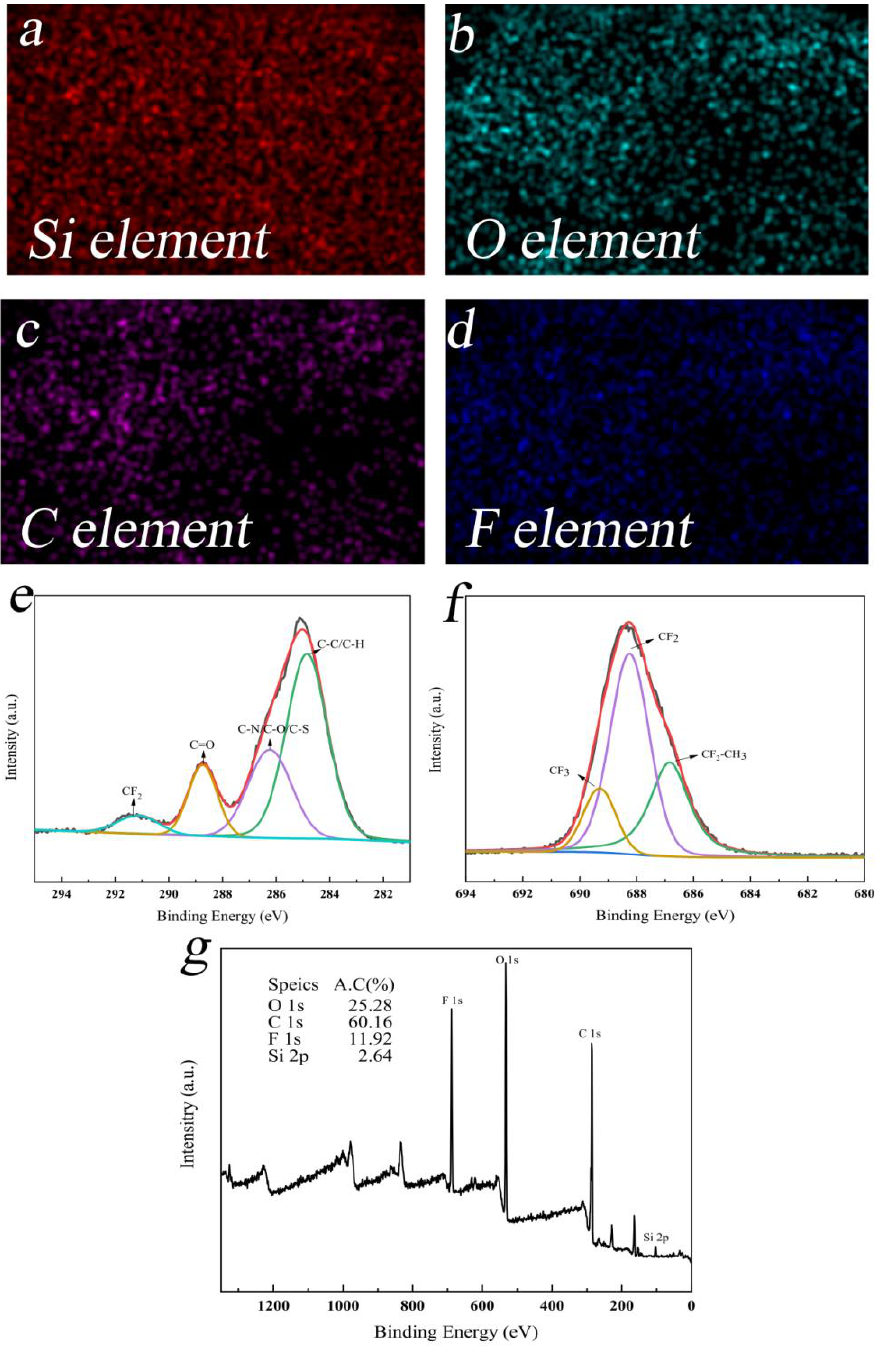
Figure 9. ( a – d ) EDS mapping, ( e ) high-resolution C1s spectra, ( f ) high-resolution F1s spectra and ( g ) XPS survey spectra of FEP-S coating.